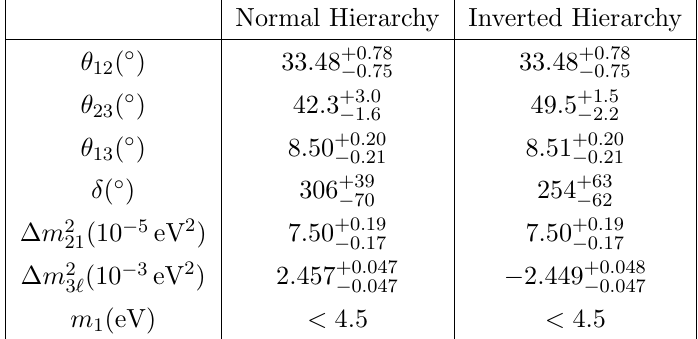
Table 2 . Best-(cid:12)t values for the SM neutrino physics parameters for the normal and inverted hierarchies. The intervals correspond to and ‘ = 2 for the inverted